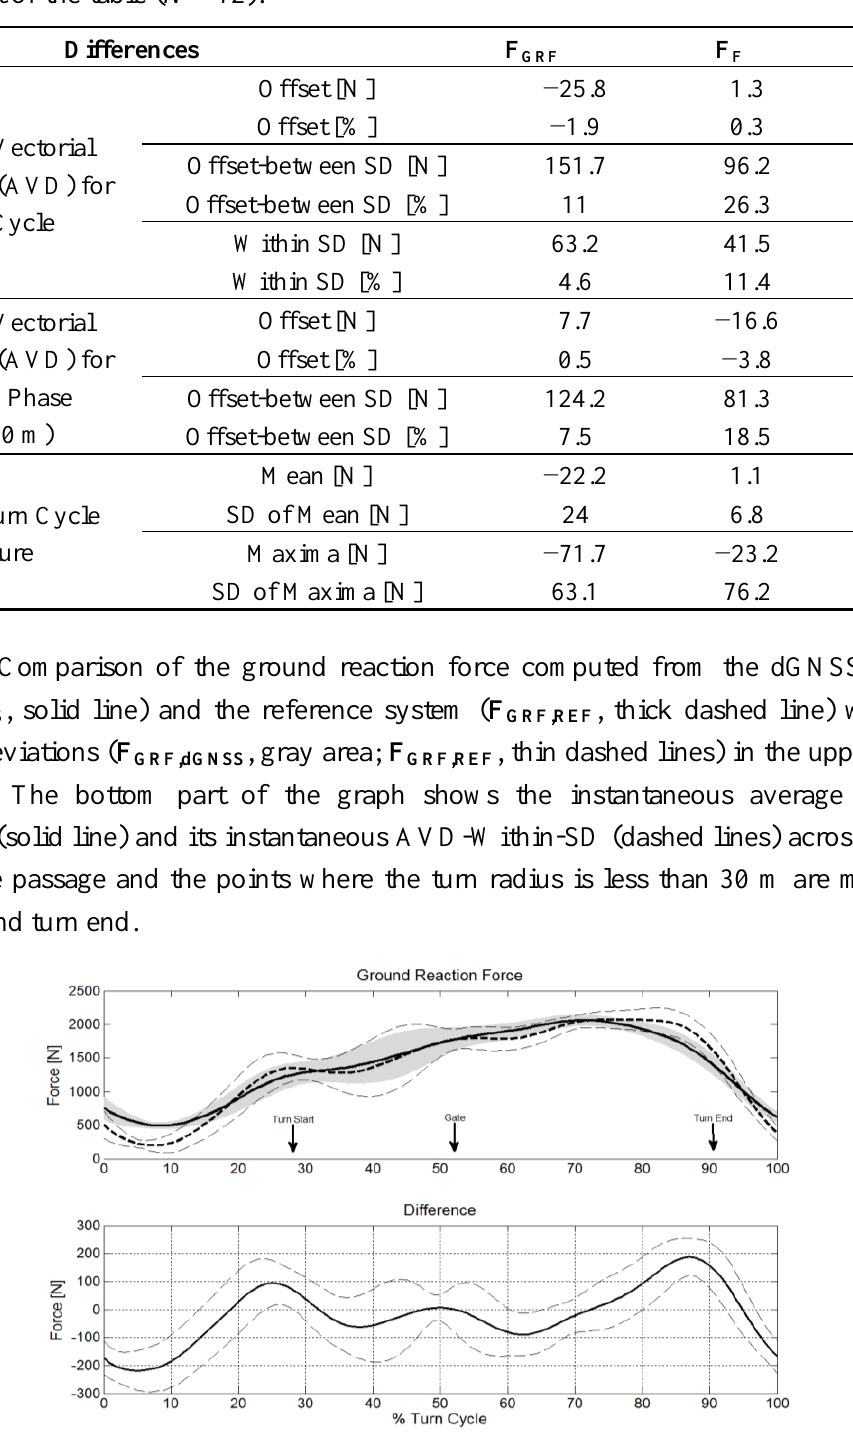
Table 1. Average vectorial difference offset, between and within standard deviation (SD) and percent difference of the ground reaction force ( F drag ( F ) for the entire turn cycle and the turning phase (turn radius < 30 m). Comparisons D of the turn mean and maximum values (typical feature of turn cycle) are given in the bottom part of the table ( N = 12).